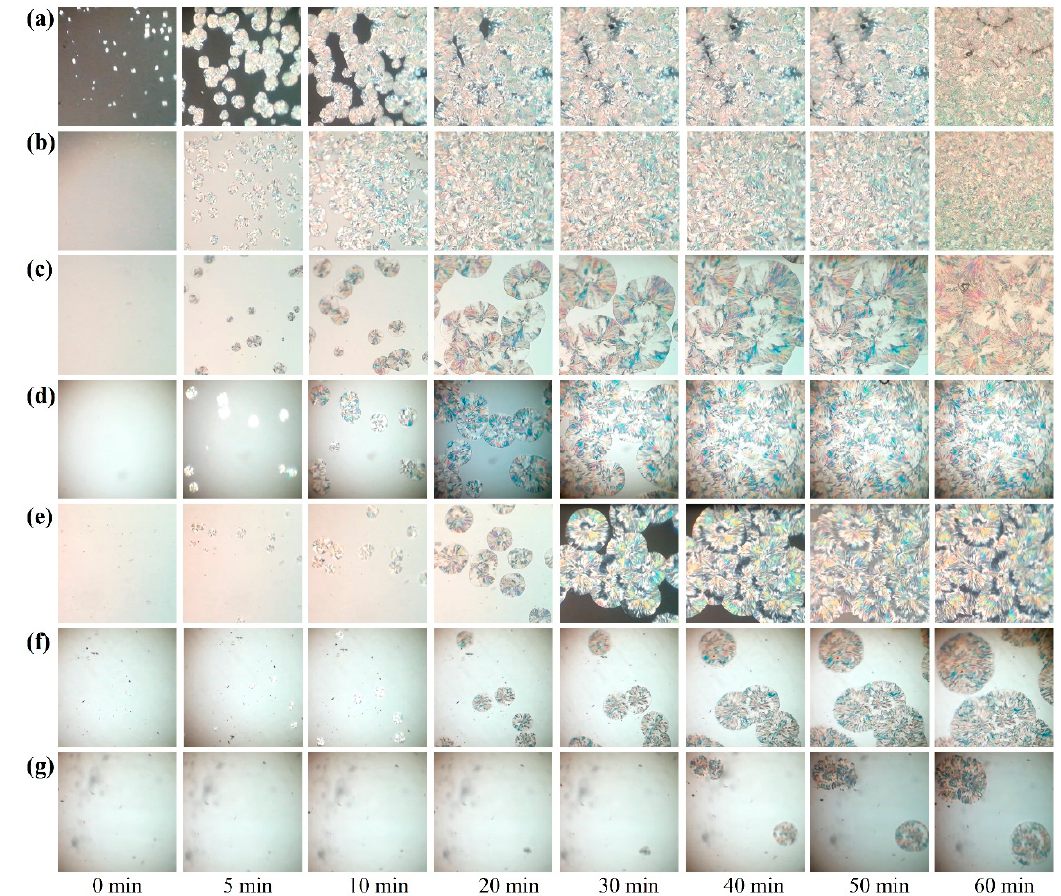
Figure 12. Polarizing optical microscopic images of ( a ) pure POM and its blends with ( b ) 10 wt %, ( c ) 20 wt %, ( d ) 30 wt %, ( e ) 40 wt %, ( f ) 50 wt %, and ( g ) 60 wt % of PLA during the isothermal crystallization process.